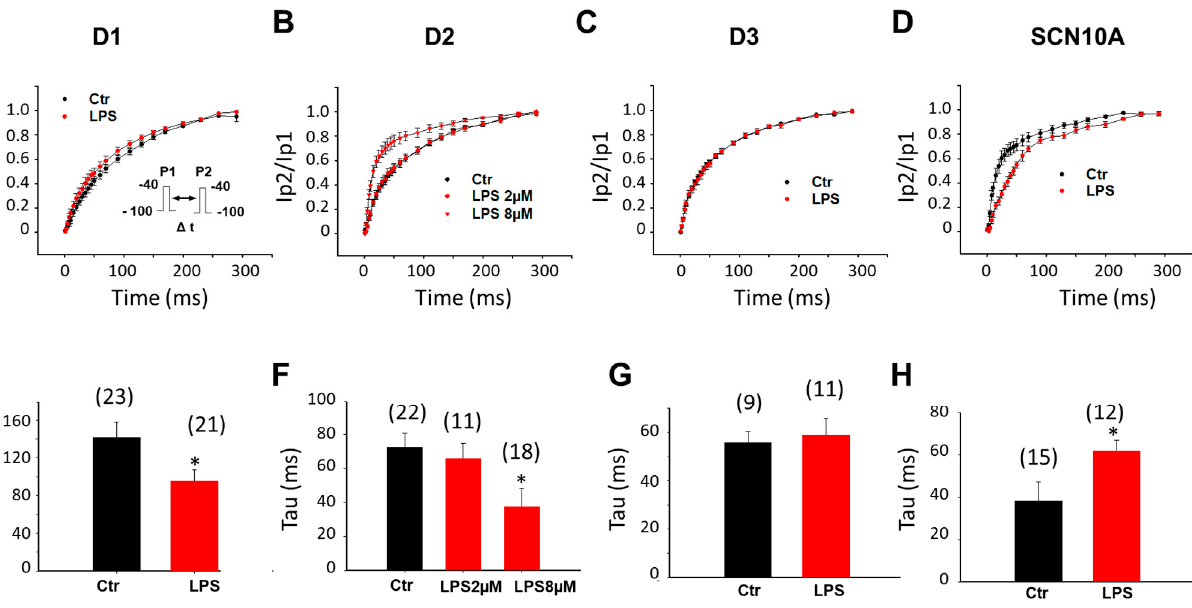
Figure 4. LPS effects on recovery from inactivation of sodium channels in hiPSC-CMs from healthy donors and the BrS-patient. Cells were treated with vehicle (Ctr) of LPS of 2 μ g/mL or 8 μ g/mL (in D2 cells) for 48 h. ( A ) Recovery curves of peak sodium channel currents (I Na ) recorded in hiPSC-CMs from D1 healthy donor. ( B ) Recovery curves of peak I Na recorded in hiPSC-CMs from D2 healthy donor. ( C ) Recovery curves of peak I Na recorded in hiPSC-CMs from D3 healthy donor. ( D ) Recovery curves of peak sodium channel currents (I Na ) recorded in SCN10A-hiPSC-CMs. ( E ) Mean values of time constant (Tau) of recovery from inactivation in hiPSC-CMs from D1 healthy donor. ( F ) Mean values of time constant (Tau) of recovery from inactivation in hiPSC-CMs from D2 healthy donor. ( G ) Mean values of time constant (Tau) of recovery from inactivation in hiPSC-CMs from D3 healthy donor. ( H ) Mean values of time constants (Tau) in SCN10A-hiPSC-CMs. Numbers given in ( E – H ) represent the number of cells of measurements also for ( A – D ). * p < 0.05 versus Ctr